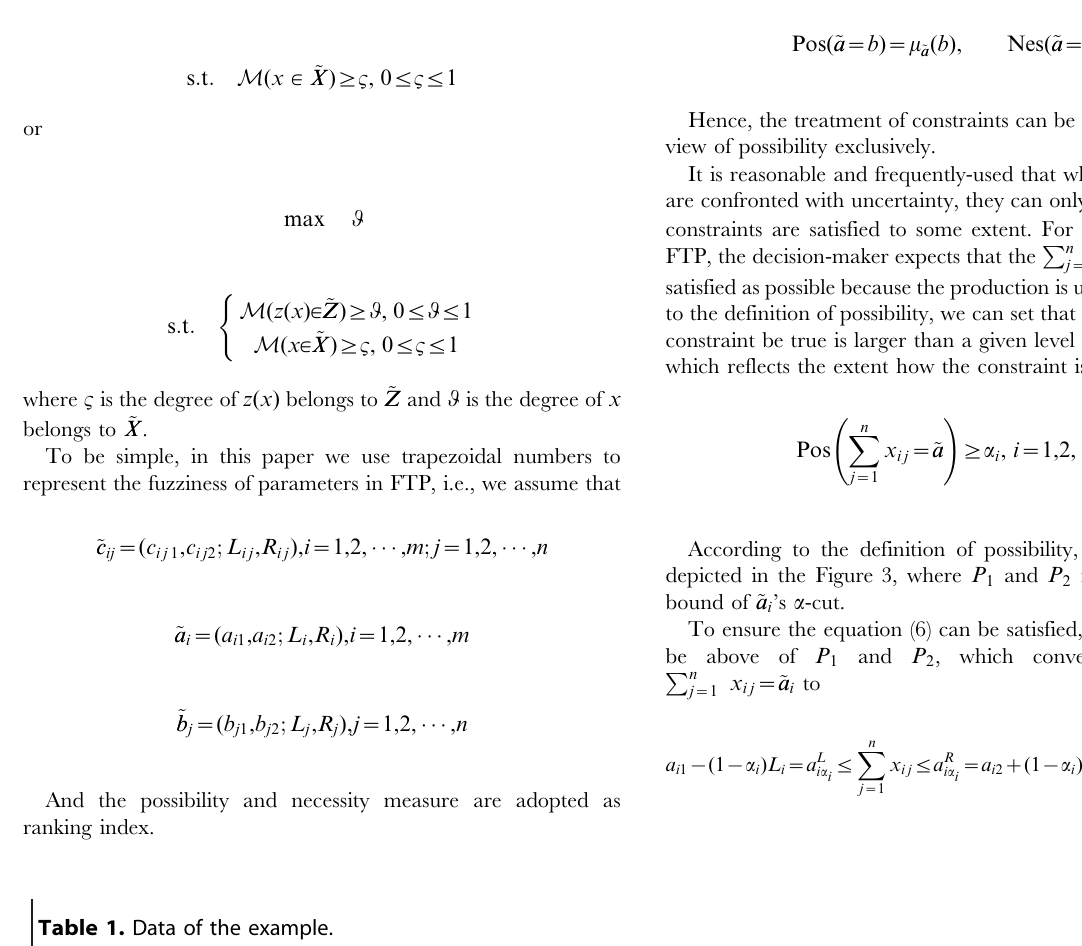
Figure 7. Treatment of objective: possibility-modality ap- proach.